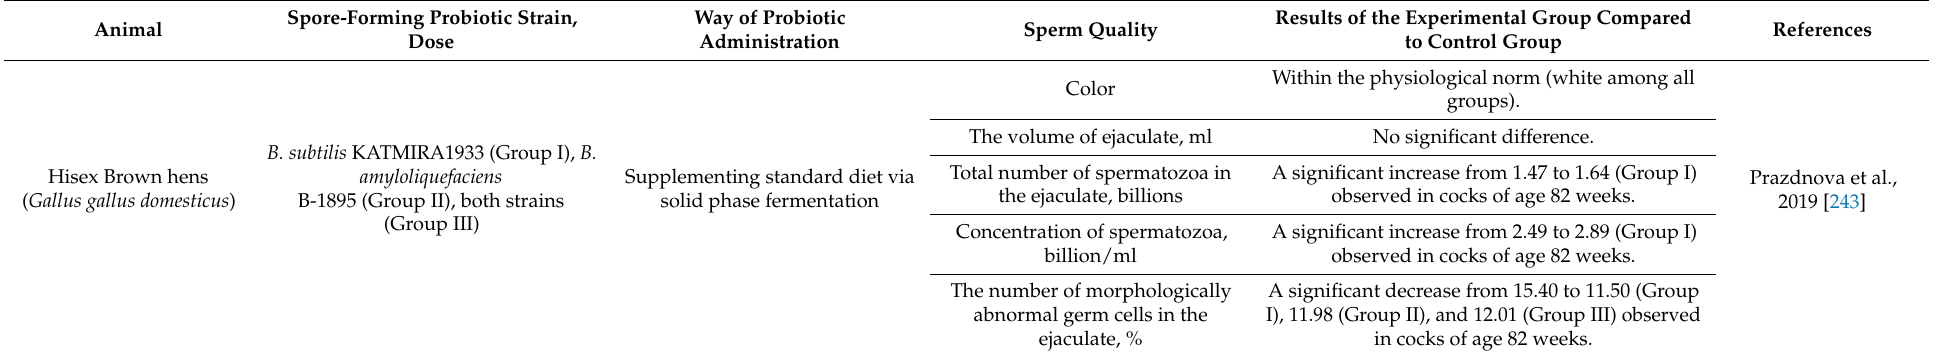
Table A3. Comparison table of studies of spore-forming probiotics effects on sperm quality characteristics in